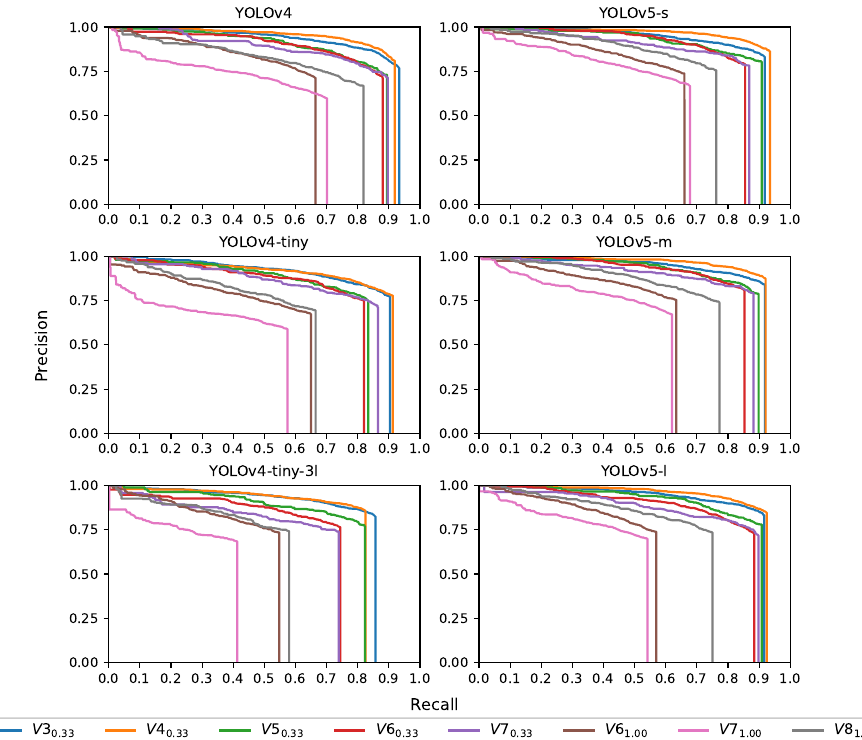
Figure 11. Recall vs. Precision curves by vegetative stage and spatial resolution. Comparing the estimation of the number of plants per image for each model, the rRMSE was obtained, Figure 12. The best results were obtained at vegetative stages V3, V4 and V5 with a GSD of 0.33 cm/pixel with rRMSE values between 10 and 20%, an error that increases at vegetative stages higher than V5.